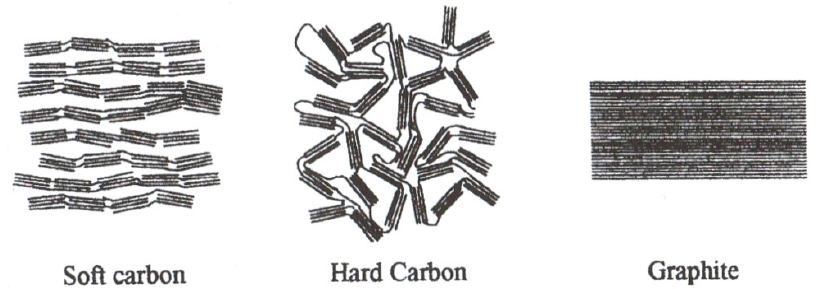
Figure 3. Illustration of carbon types showing different stacking of the graphene layers. Reprinted from [68] with permission from Elsevier.